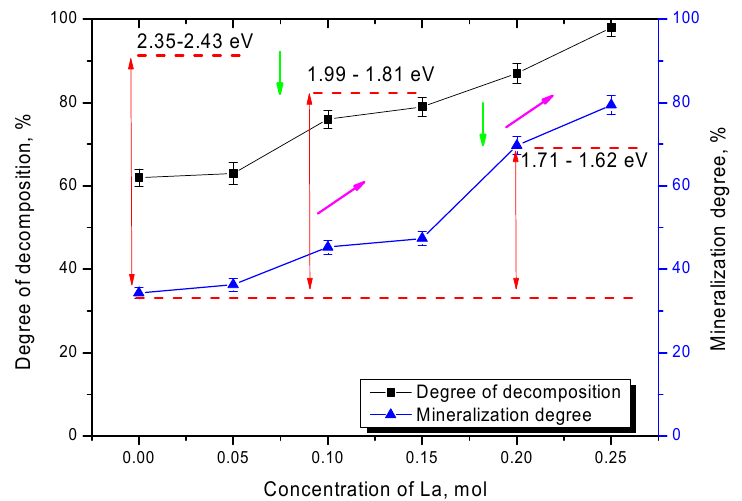
Figure 7. Dynamics of the dependence of the values of decomposition efficiency and mineralization of decomposition products on type of ceramics, as well as changes in the band gap width of ceramics (green arrows indicate changes in the band gap width; crimson arrows reflect the dynamics of increasing the photocatalytic decomposition efficiency).